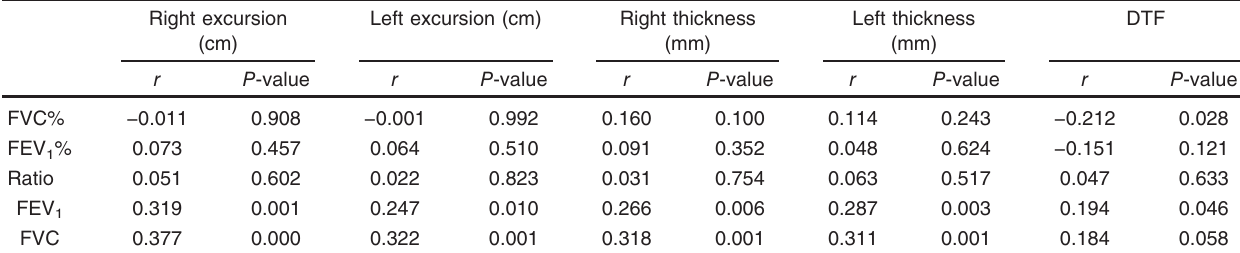
Table 9 Relation between spirometric parameters and ultrasound diaphragmatic parameters in all persons Right excursion Left excursion (cm) (cm)